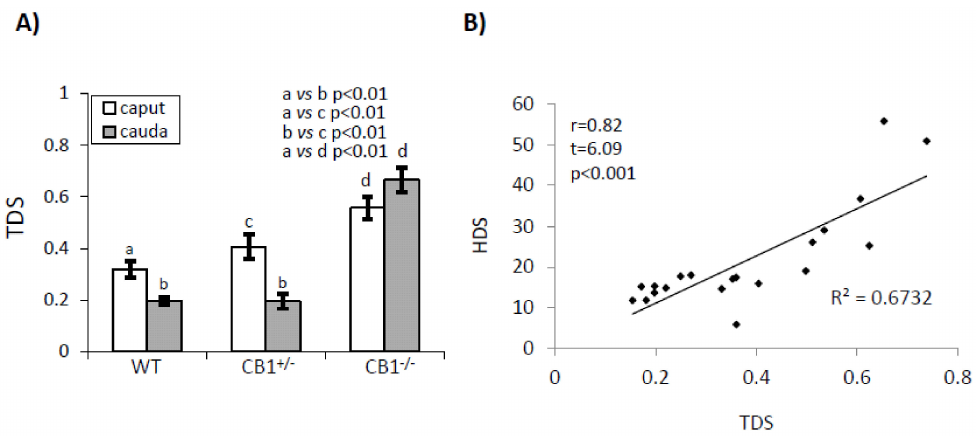
Figure 2. Flow cytometry analysis of sperm from caput and cauda epididymis of WT, CB1 +/ - , and CB1 - / - stained with AO. Green (FL1-H > 10 1 ) and red (FL3-H > 10 1 ) fluorescent DNA were used to analyze: ( A ) TDS (used as index of thiol groups oxidation) values. Graphs were representative of four sperm samples / animal / genotype ( n = 4 animals for each genotype in triplicates). Data were expressed as the mean ± S.E.M. Di ff erent letters indicated statistical significance ( p < 0.05 or p < 0.01). ( B ) Correlation analysis between HDS and TDS values relative to caput and cauda SPZ of WT, CB1 +/ - and CB1 - / - , independently by genotype and epididymal region ( r = 0.82, p <